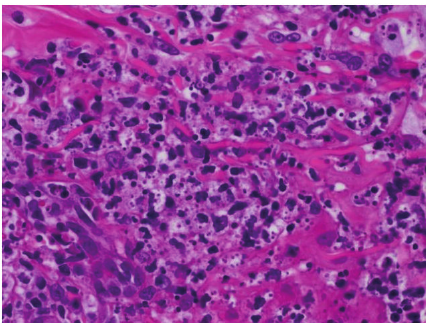
Figure 4: High-power H&E: parasitized histiocytes with amastig- otes present.